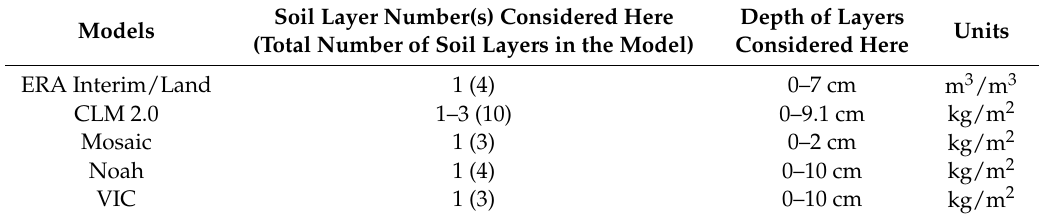
Table 2. The soil layers of five land surface models used in this